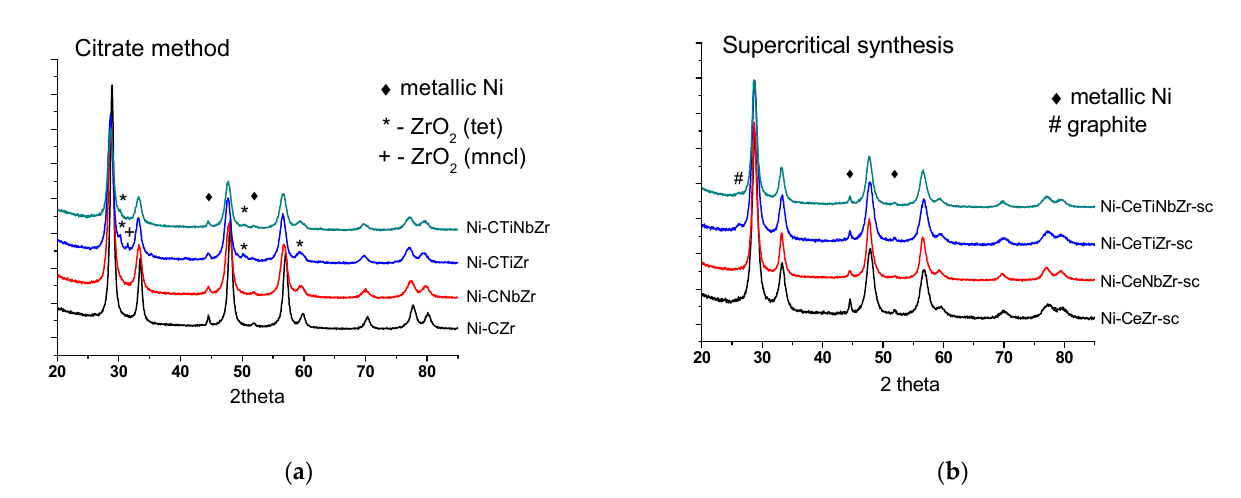
Diffraction patterns of catalysts after tests in methane dry reforming are presented in Figure 6. The ceria–zirconia mixed oxide structure persists under reaction conditions. Trace amounts of zirconium oxide in citrate samples are due to preparation features and remained unchanged after reaction. The weak peak at 26° corresponding to graphitic carbon (PDF 075-0444) appeared for supercritical catalysts modified by Ti that may be due to a higher content of carbon deposits on their surface.